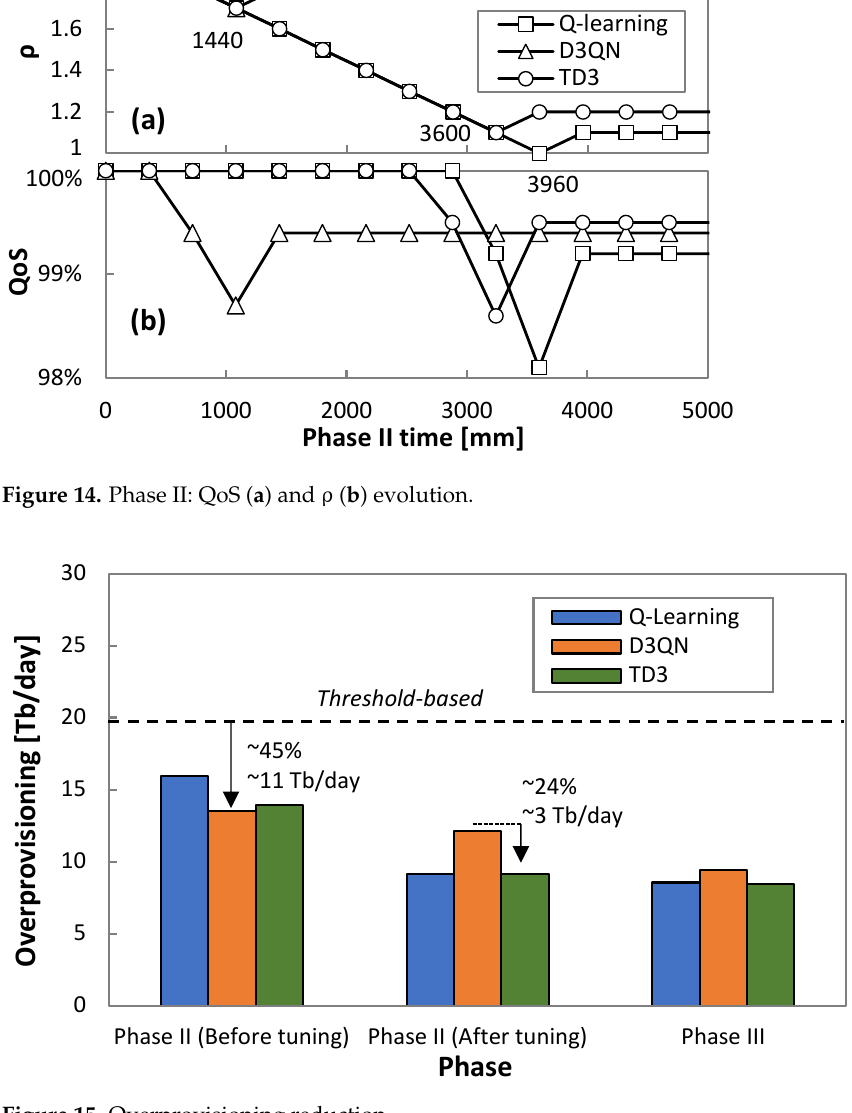
Figure 15. Overprovisioning reduction.